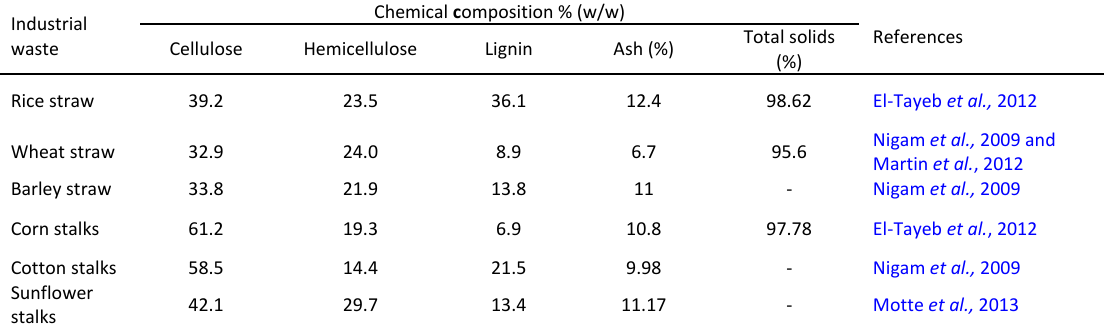
Table 2: Agriculture industrial waste chemical composition